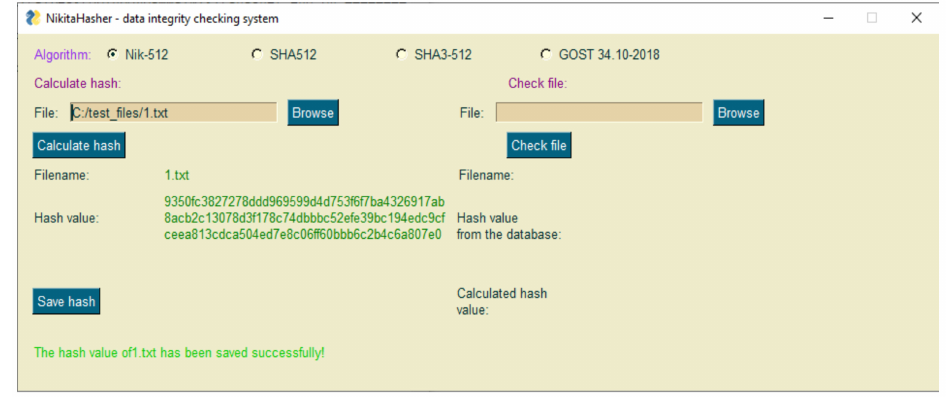
Figure 5. Hash value calculation and saving.